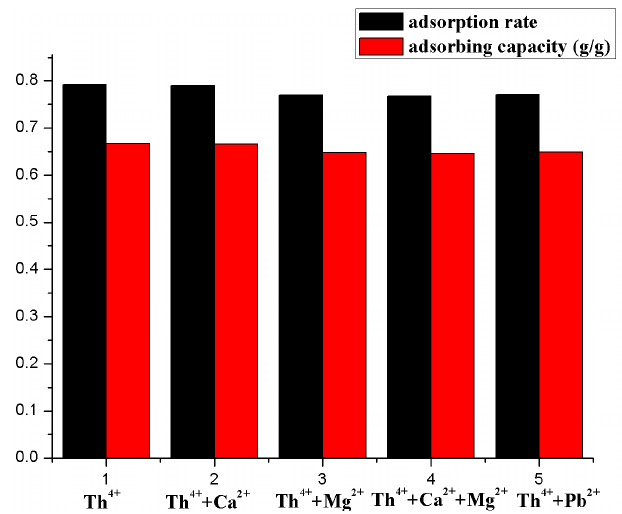
Figure 13. T Effect of interfering ions on the adsorption of Th(IV) onto β -CD(AN- co -AA).